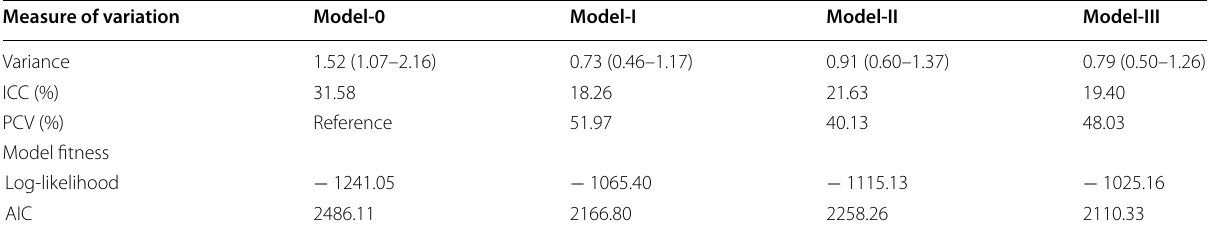
ICC intra-class Correlation Coefficient, PCV proportional change in variance, AIC Akaike Information Criterion